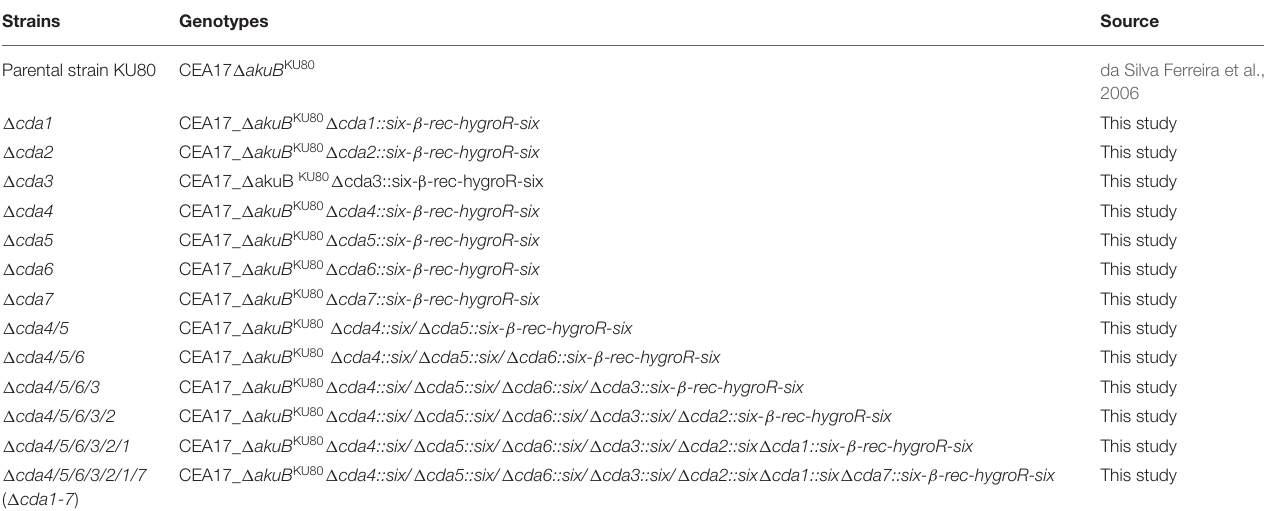
TABLE 1 | Fungal strains used and constructed in the present study. Strains